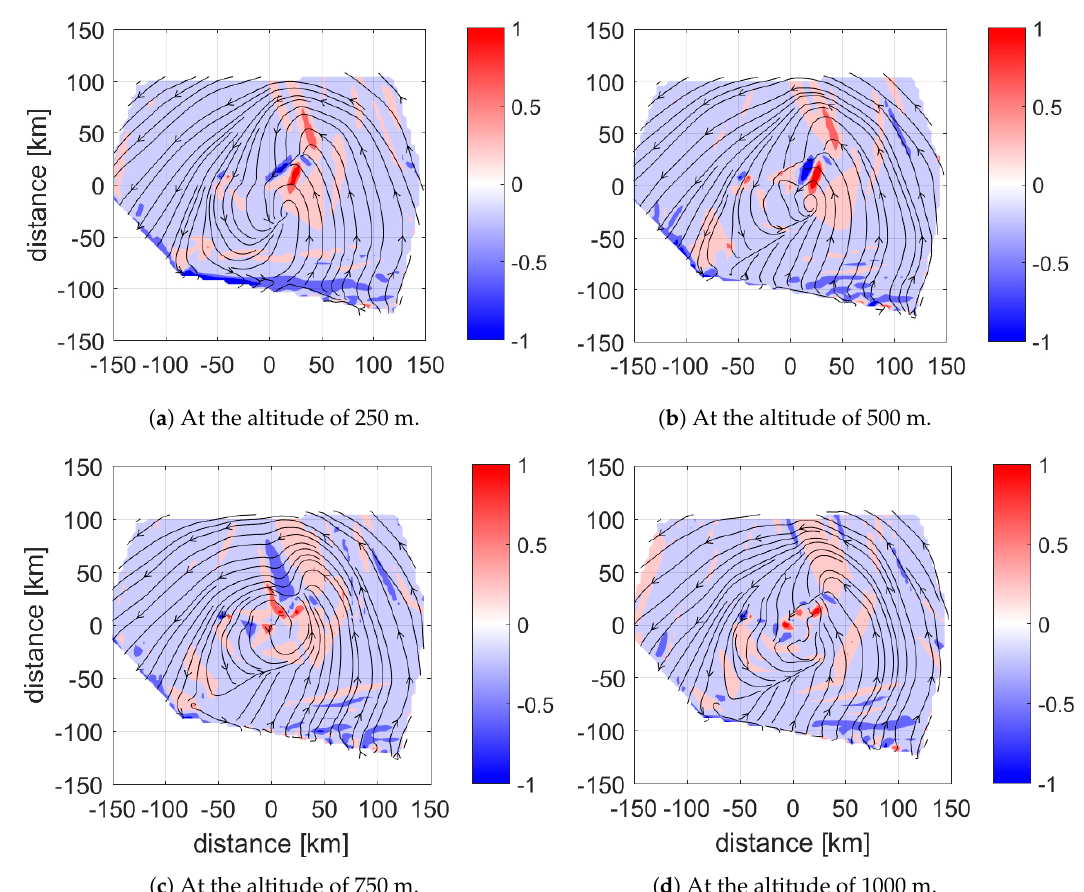
Figure 12. Contours of relative vorticity calculated from LiDAR measurements [166]. Black lines denote the